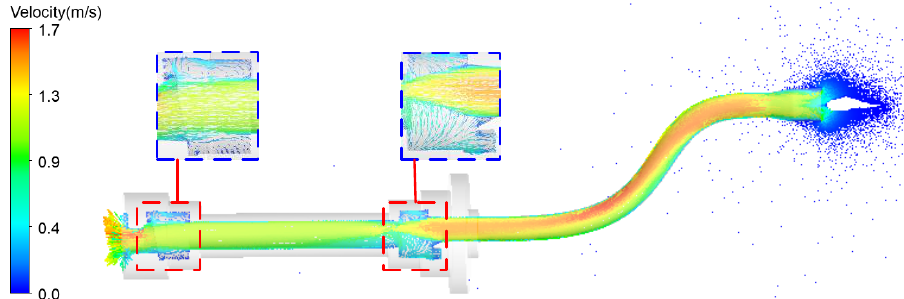
Figure 7. Velocity vector distribution of HSMPS flow field.